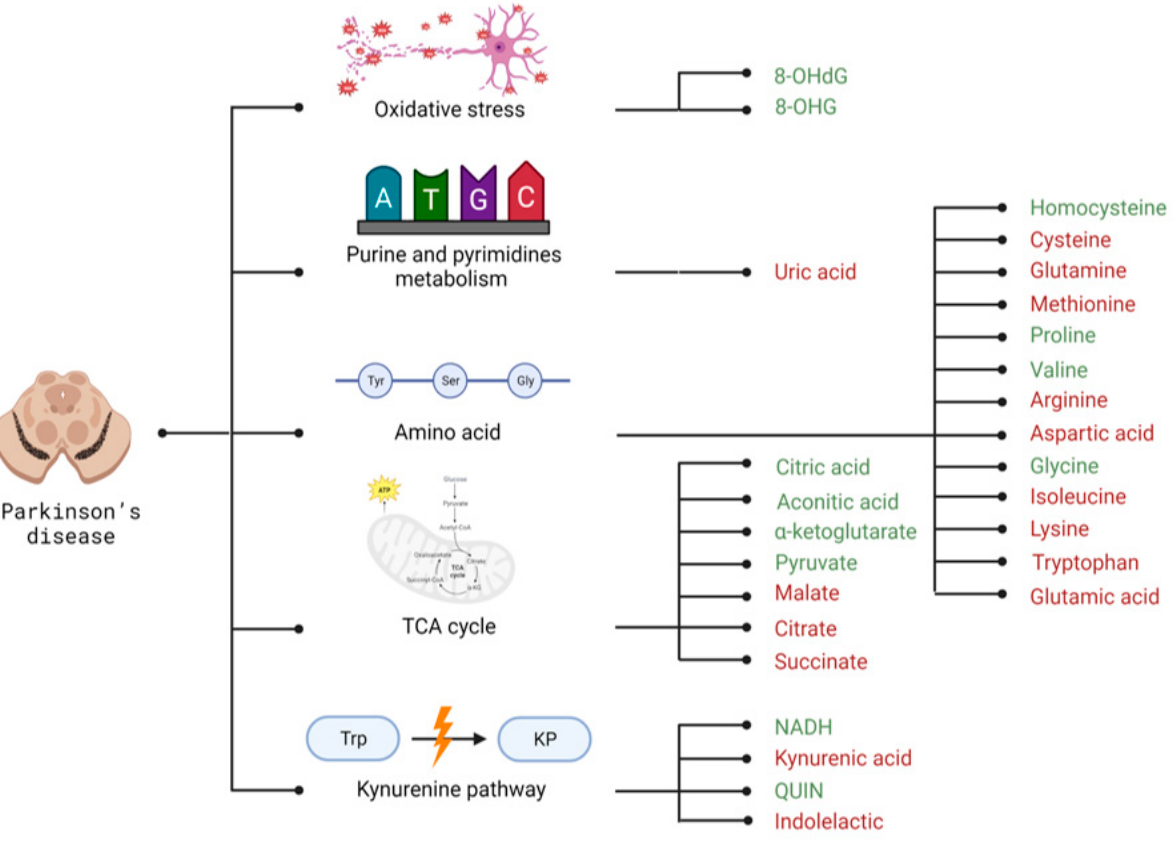
Figure 3. Biomarkers of PD related to energy metabolism disruption (green—increased levels, red—decreased levels).